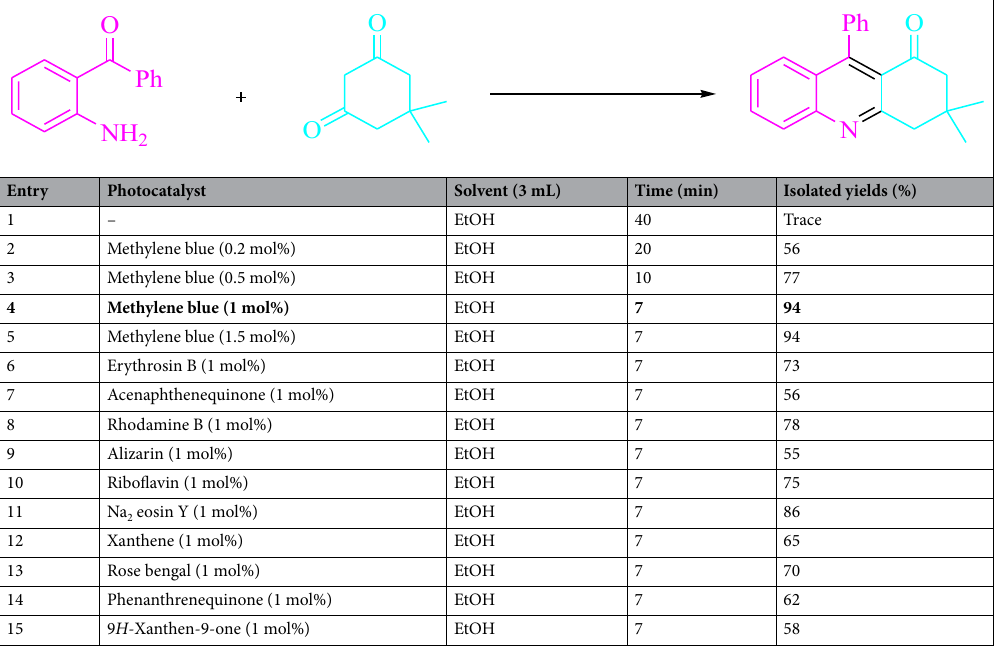
Table 1. Table of photocatalyst optimization for 3a production. Reaction conditions: At room temperature, 2-aminobenzophenone (1.0 mmol) and dimedone (1.5 mmol) in EtOH were used, along with a white LED (12 W) and a variety of photocatalysts. Significant values are in